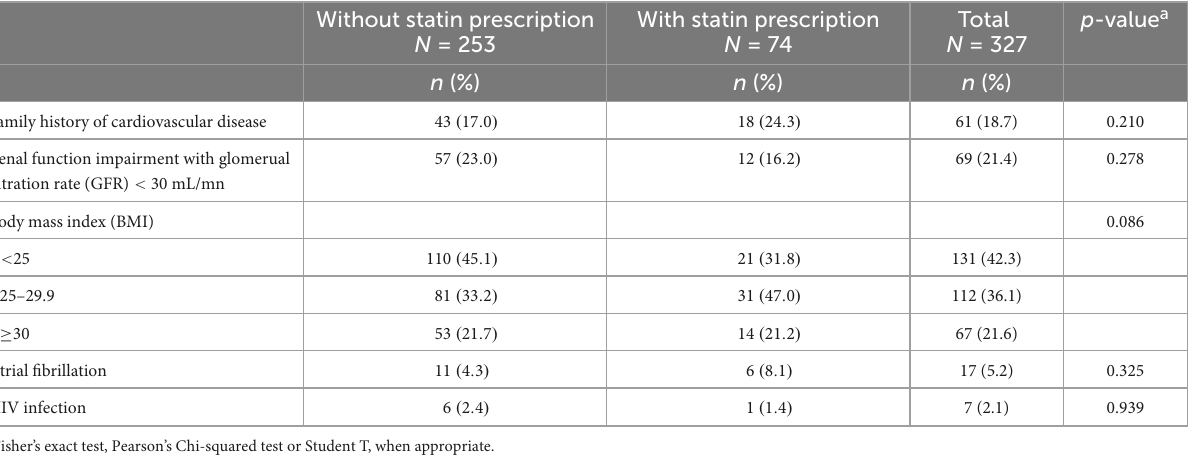
TABLE 2 Rates of statin therapy prescribed in accordance with different